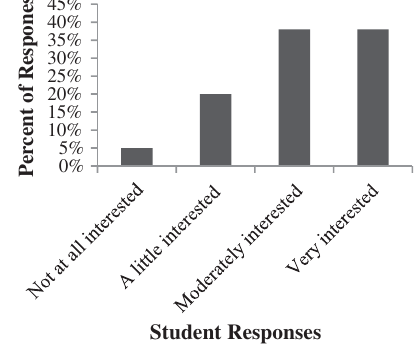
FIG. 4. Self-reported interest in